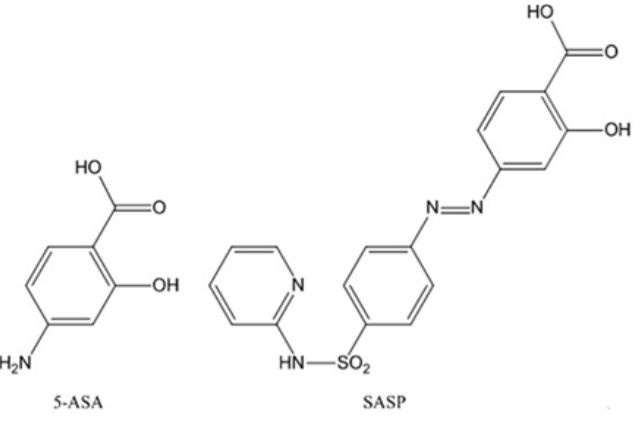
Figure 1. The structures of 5-aminosalicylic acid (5-ASA) and salicylazosulfapyridine (SASP) [28].